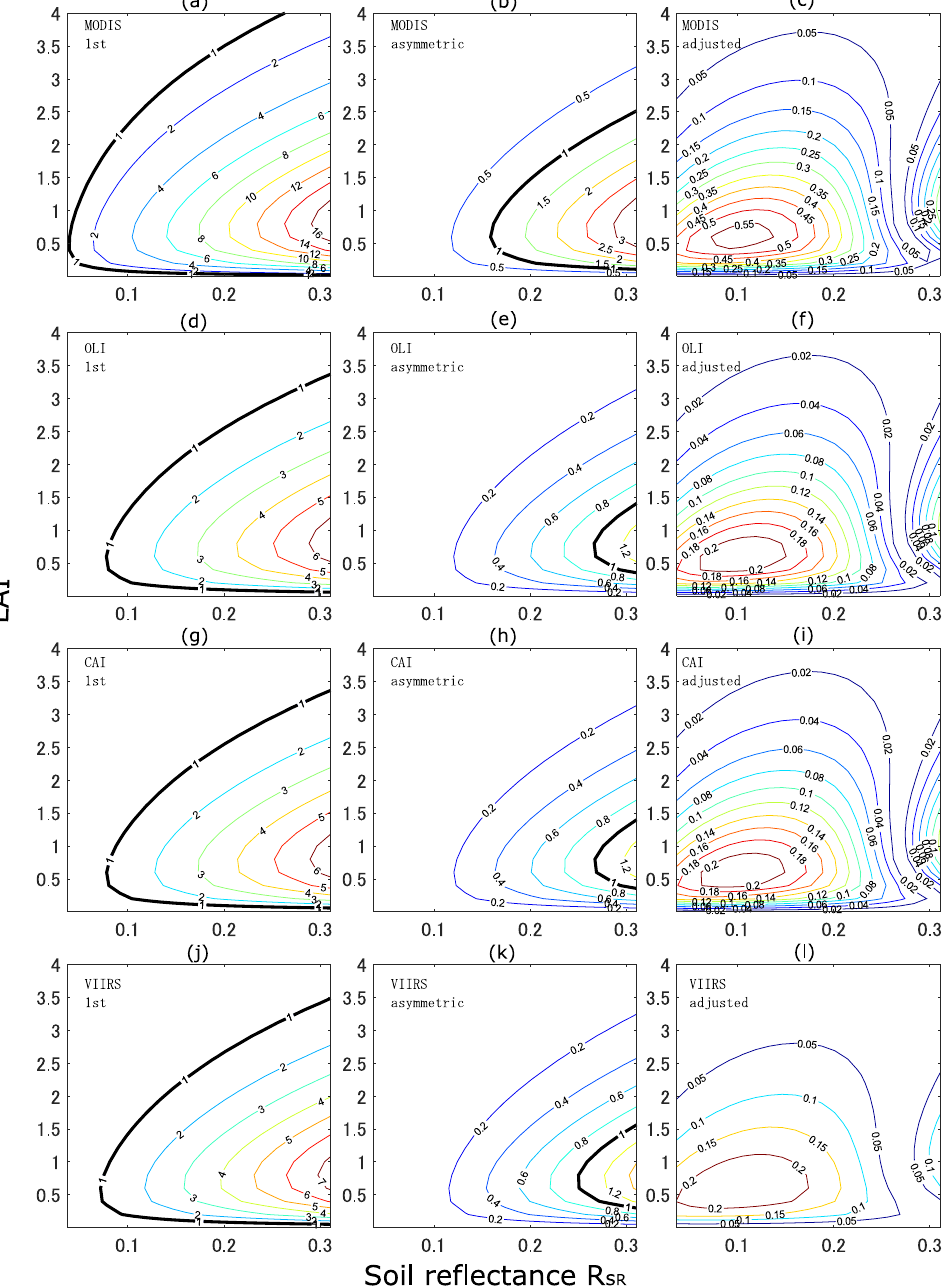
Figure 8. Contour plots of r over LAI- R sr space. From the top to the bottom, each plot correspond to the MODIS (a, b, c), OLI (d, e, f), CAI (g, h, i), and VIIRS (j, k, l) sensors, respectively. From the left to right column, each plot corresponds to the first-order (a, d, g, j), asymmetric-order (b, e, h, k), and adjusted asymmetric-order (c, f, i, l) (with k opt = 1.29) isoline equations, respectively. The bold line indicates r = 1.0. ( a ) MODIS-first; ( b ) MODIS-asymmetric; ( c ) MODIS-adjusted; ( d ) OLI-first; ( e ) OLI-asymmetric; ( f ) OLI-adjusted; ( g ) CAI-first; ( h ) CAI-asymmetric; ( i ) CAI-adjusted; ( j ) VIIRS-first; ( k ) VIIRS-asymmetric; ( l )